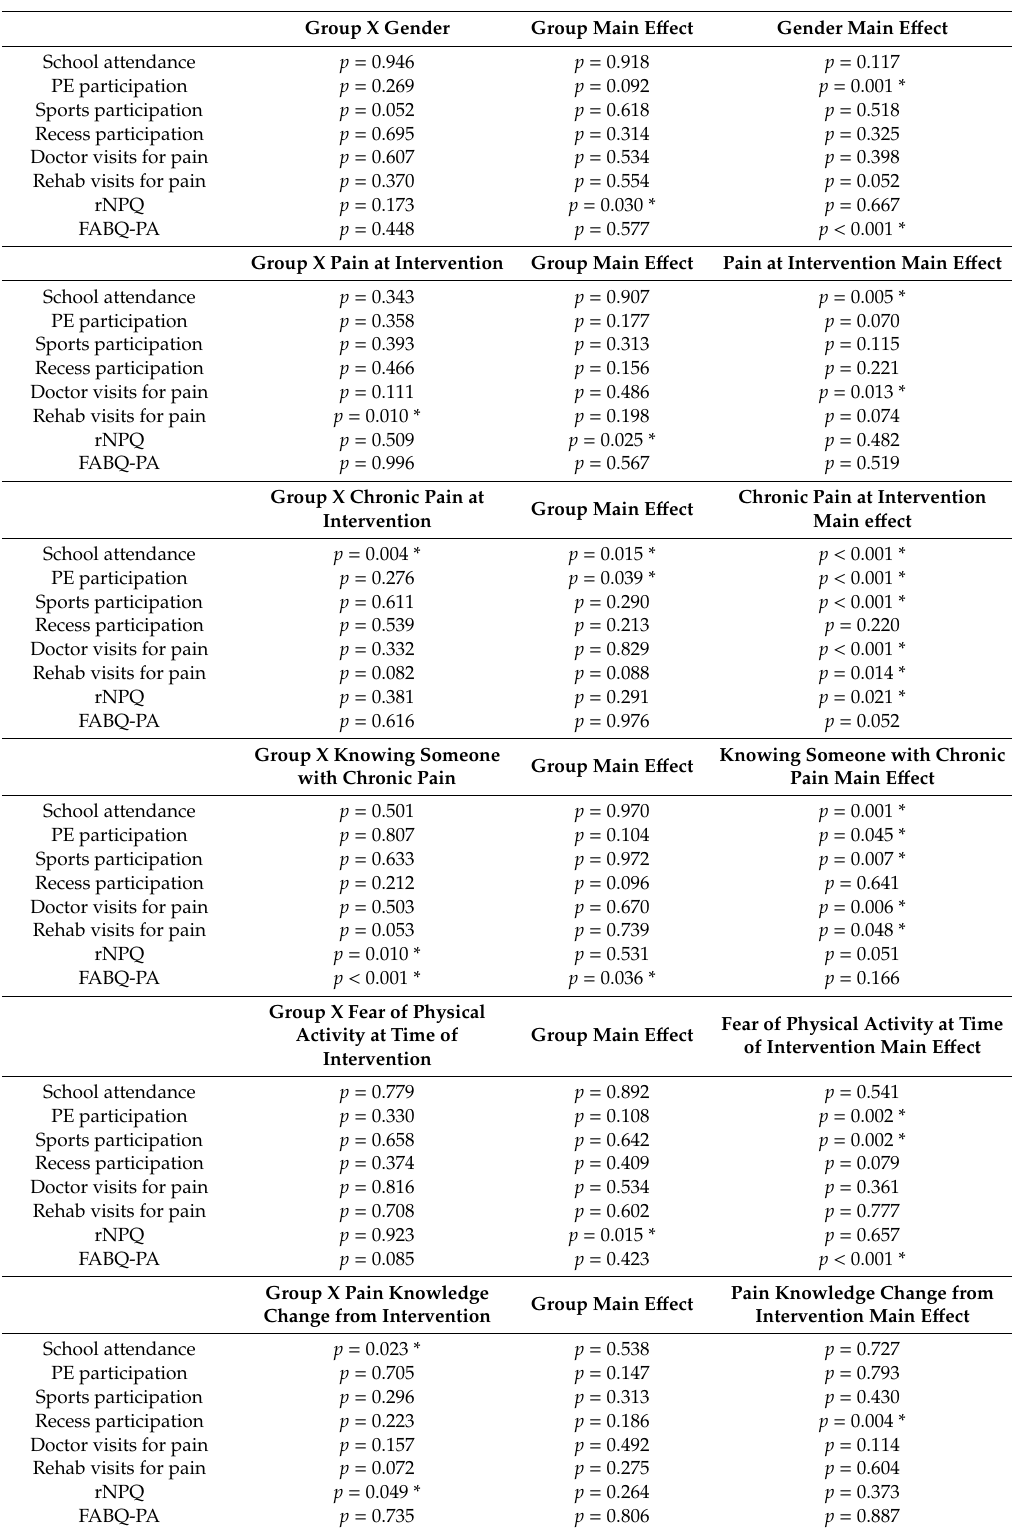
Table 3. p -Values for the interactions and main e ff ects among group by demographic variables for each of the 6-month